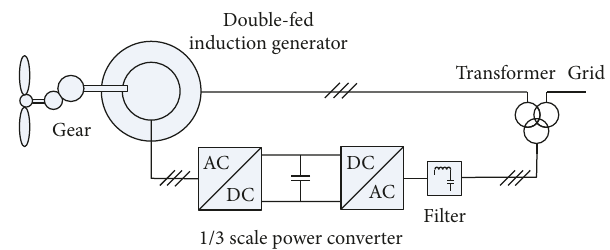
Figure 1: Configuration of a doubly fed induction generator wind energy conversion system